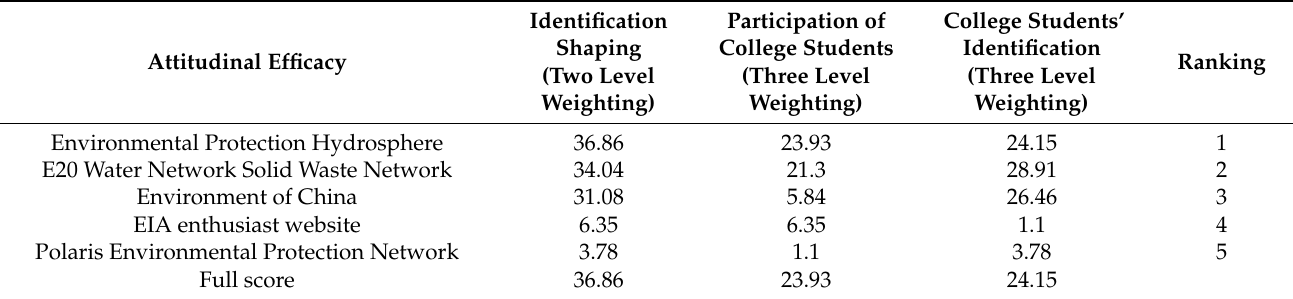
Table 11. Score and Ranking of Attitude